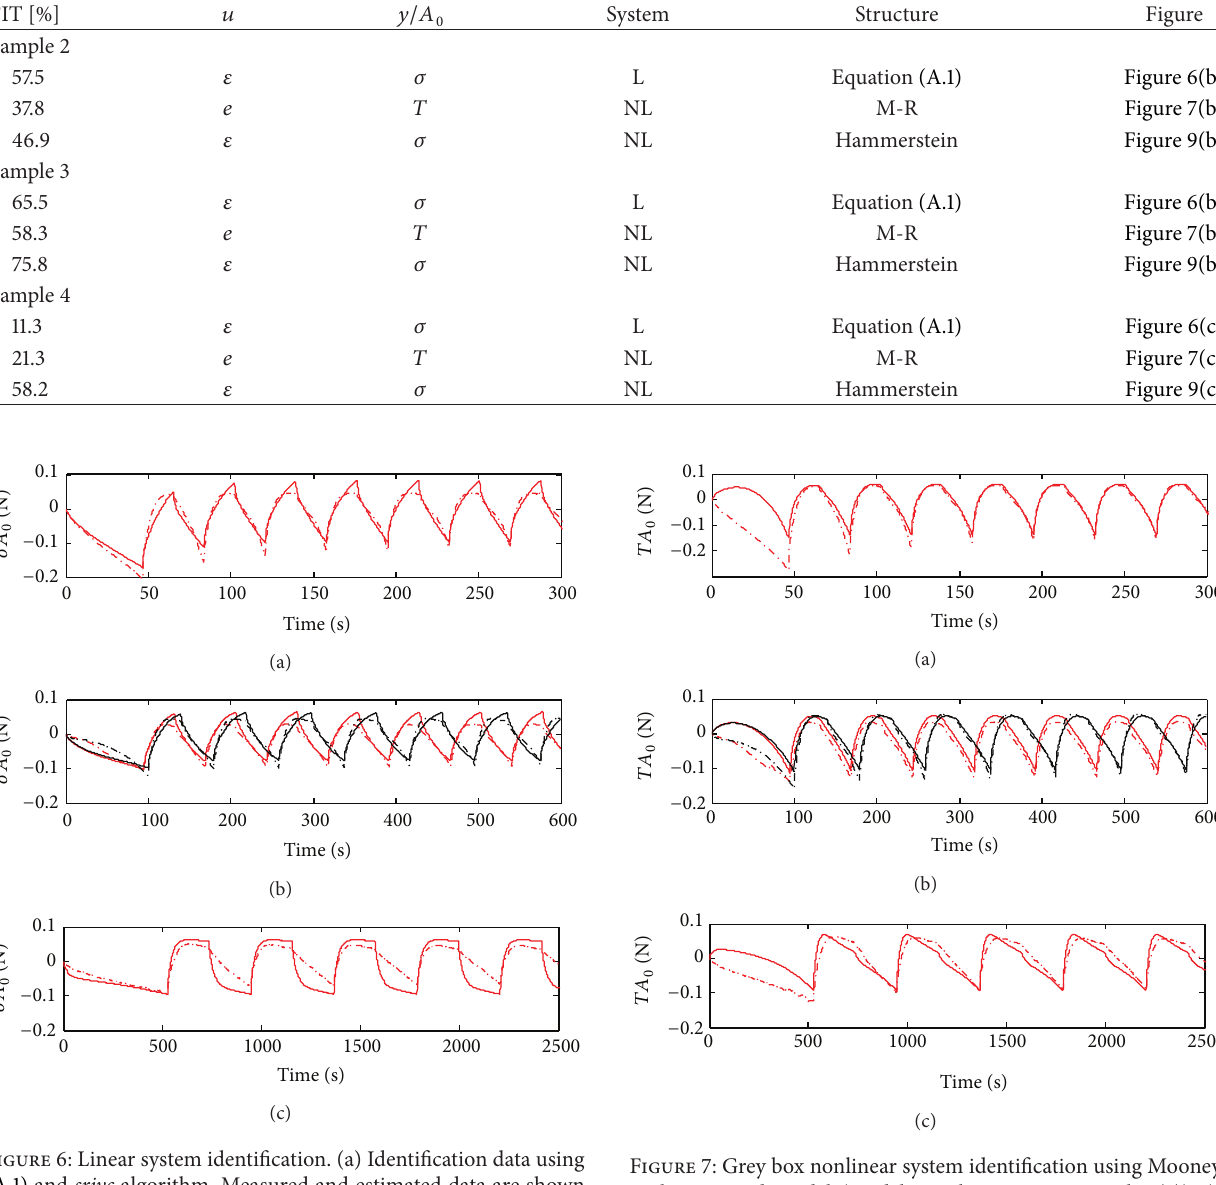
8(b) and 8(c)). Strictly, it can not be concluded that this